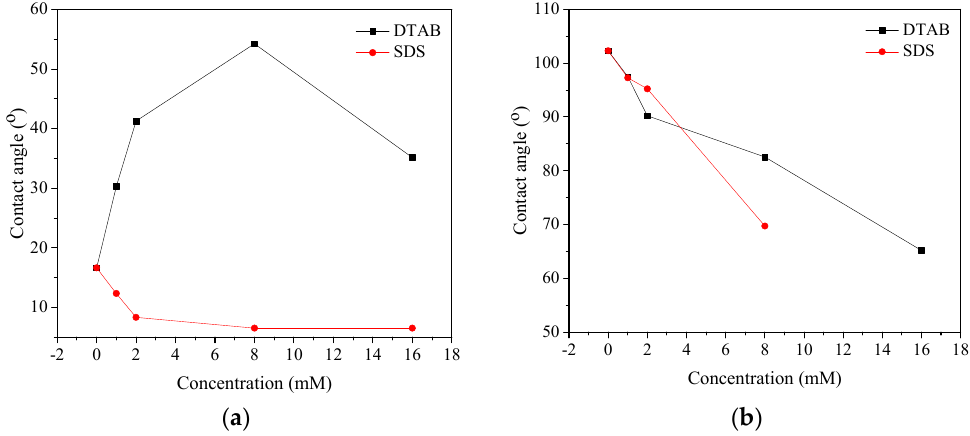
Figure 11. Effect of DTAB and SDS on the water contact angle of hydrophilic/hydrophobic glass surface. The left is hydrophilic glass ( a ) and the right is hydrophobic glass ( b ).